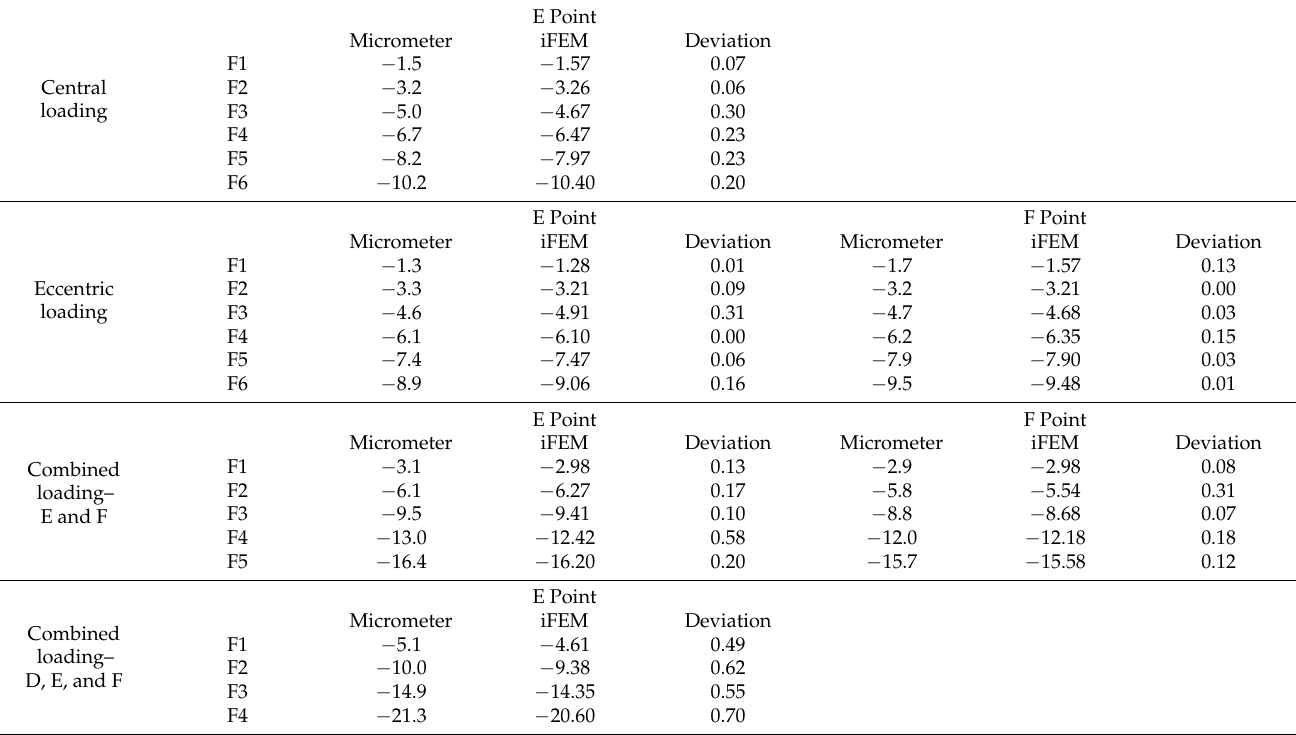
Table 2. Detailed list of